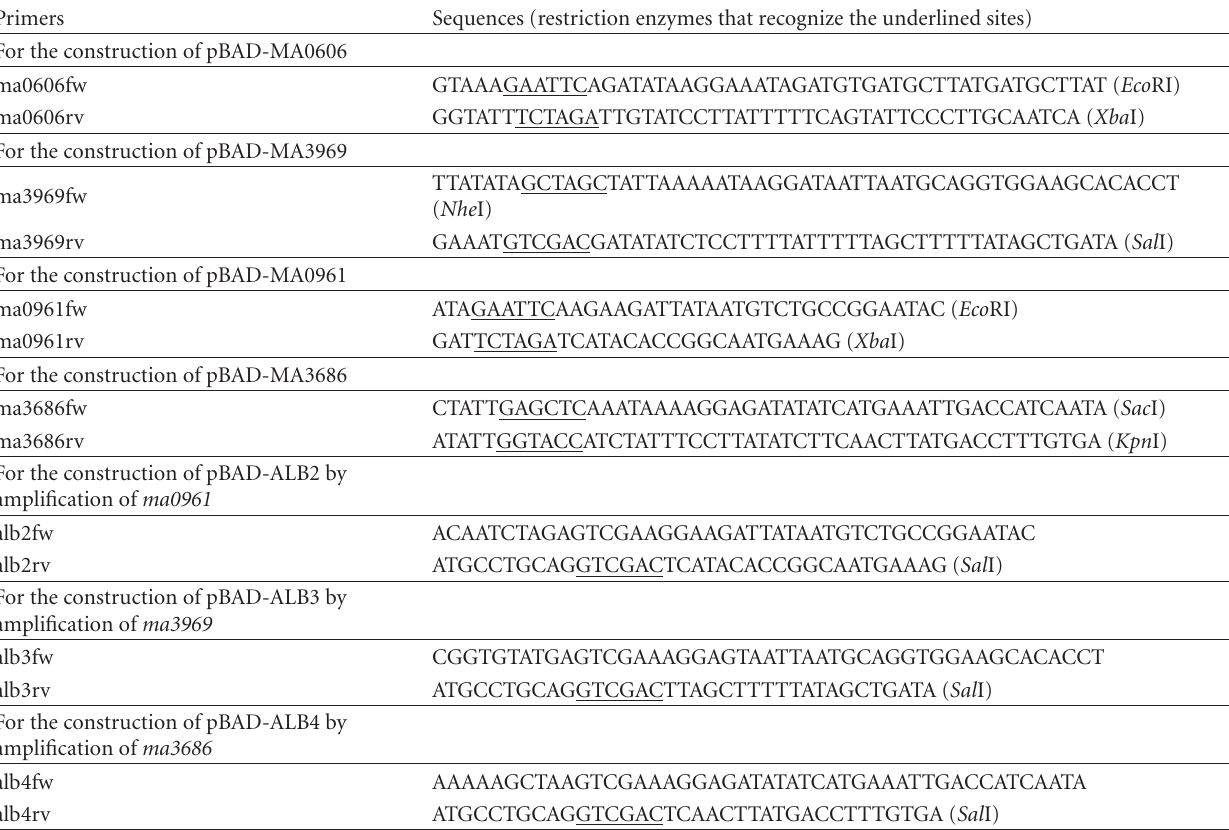
Table 1: Primers used for plasmid